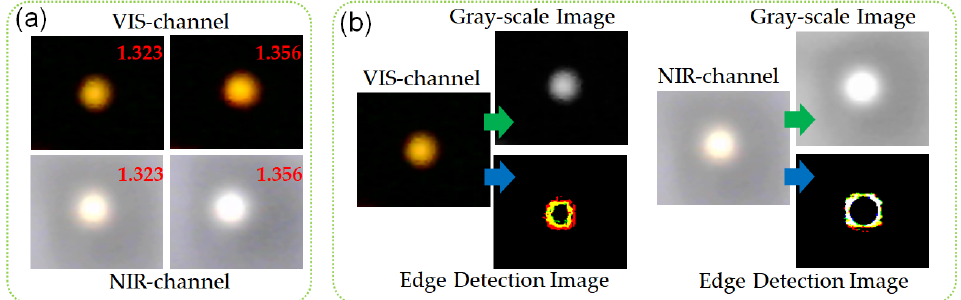
Figure 2. ( a ) Experimentally measured transmissions of optical fiber SPR sensors at RIs of 1.323 and 1.356; ( b ) VIS and NIR images of fiber end face converted into grayscale and edge detection images.